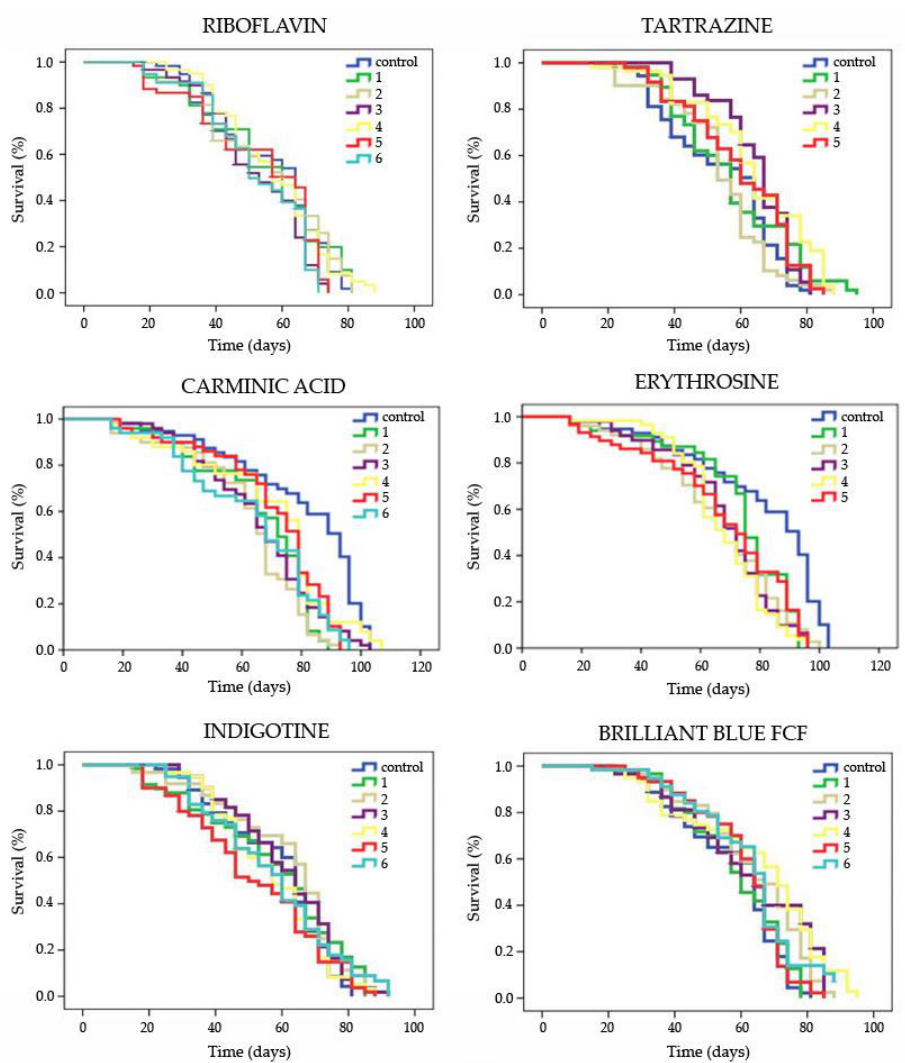
Figure 3. Complete survival curves of D. melanogaster fed with different concentrations of food colorings. The numbers 1–6 indicate the different dilutions tested (see Table 1). Curves were obtained by the Kaplan–Meier method, and significance was determined by the Log-Rank method (Mantel-cox).